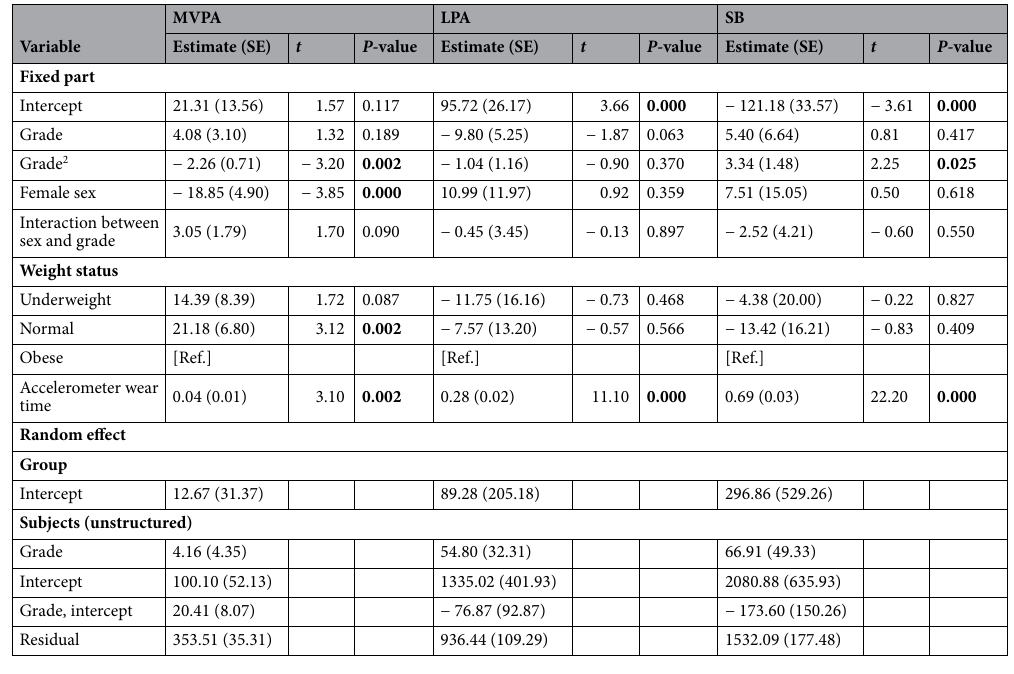
Table 4. Linear mixed models using the restricted maximum likelihood method with adjustments for the fixed effect of sex and the interaction between sex and grade in this five-year longitudinal study on physical activity in children transitioning from primary to secondary school. Estimated values of the fixed and random effects are reported by the regression coefficient and variance, respectively. Group effect described the two groups recruited in grade 4 in 2015 (n = 32) and 2016 (n = 31), with differences at the time of baseline data collection. Significant values are in bold. MVPA moderate-to-vigorous physical activity, LPA light physical activity, SB sedentary behavior, SE standard error, Ref reference